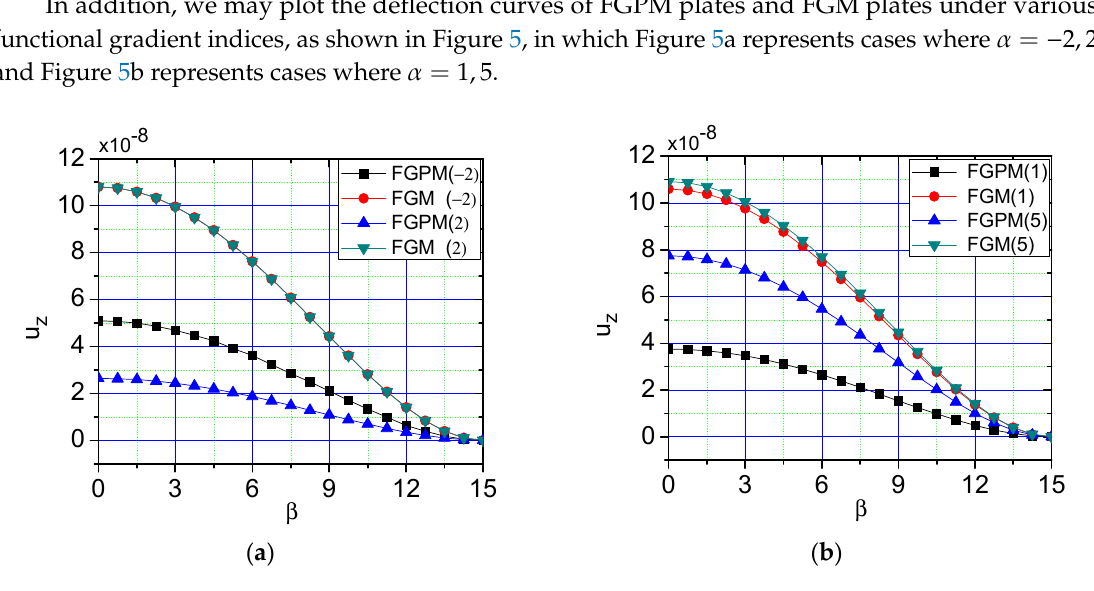
Figure 5. Deflection curves of FGPM plates and FGM plates: ( a ) α = − 2 and 2, ( b ) α = 1 and